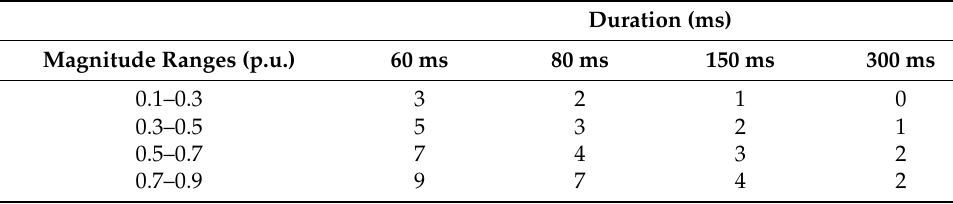
Table 5. Frequency of sag for duration and magnitude ranges for bus 15.